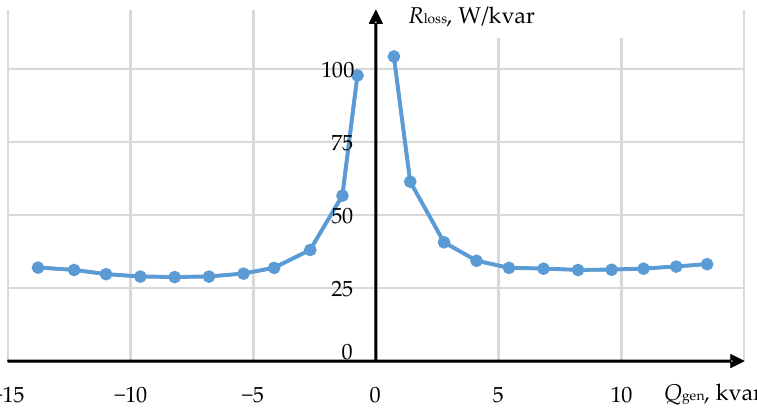
Figure 9. Per kvar power losses measured during the reactive power generation mode.